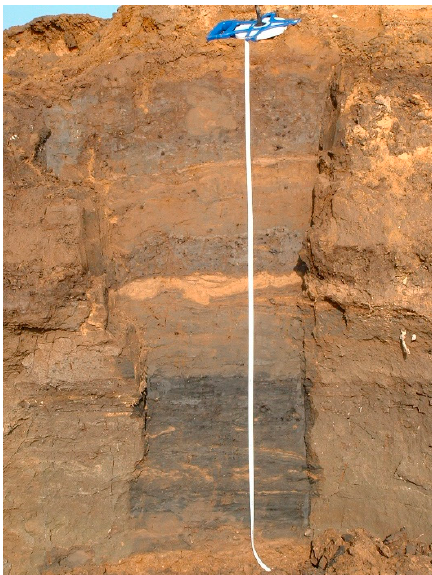
Figure 10. Illustration of the upper alluvial channel fill at Ripon South Section 1, a different and later section to that shown in Figure 9, showing layers of sands and silts, some of which are more organic. The tape is 2 m in length.